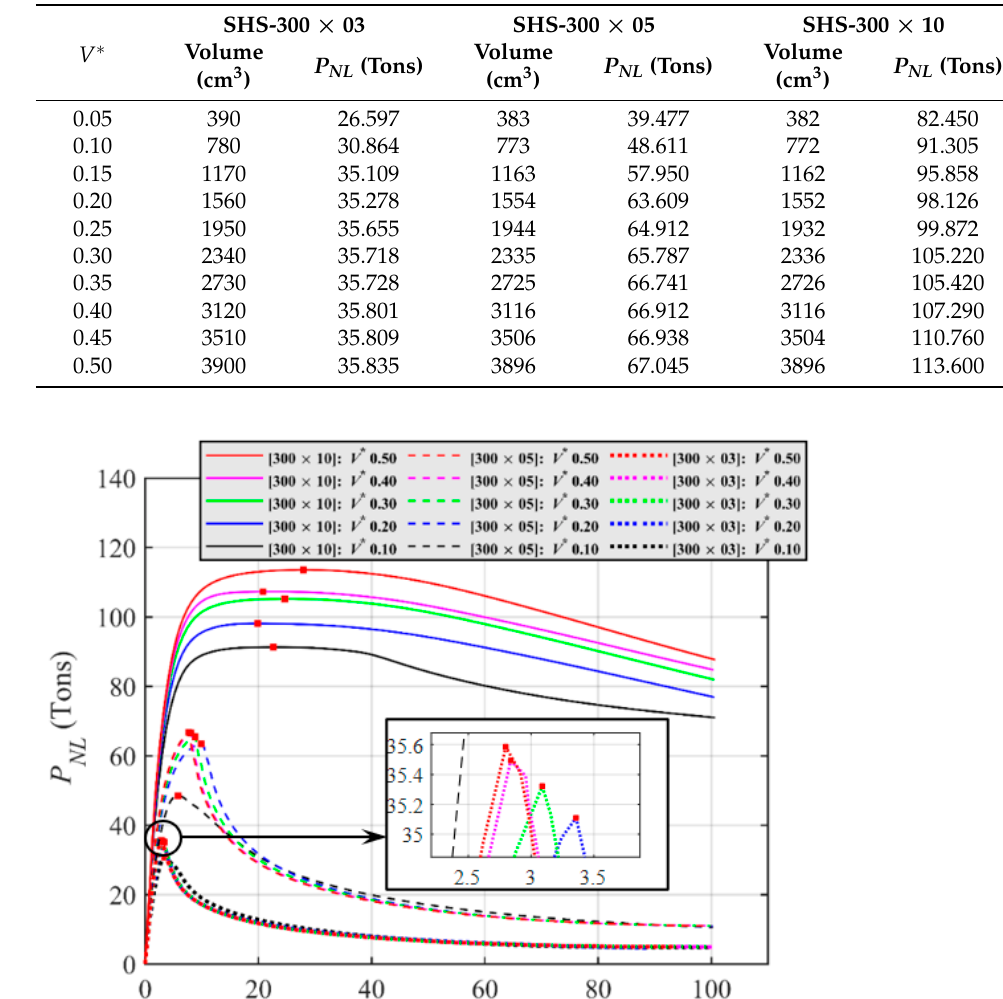
Table 3. Maximum crane loads of SHS columns with optimal-topology stiffeners.